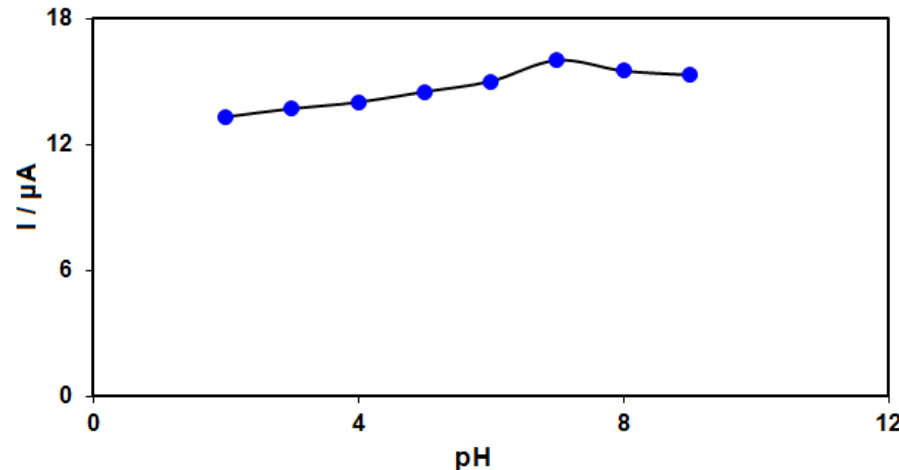
Figure 5. Plot of Ip vs. pH obtained from DPVs of MnO 2 NR-IL/CPE in a solution containing 50.0 μ M of SAA in 0.1 PBS with different pHs (2.0, 3.0, 4.0, 5.0, 6.0, 7.0, 8.0 and 9.0).